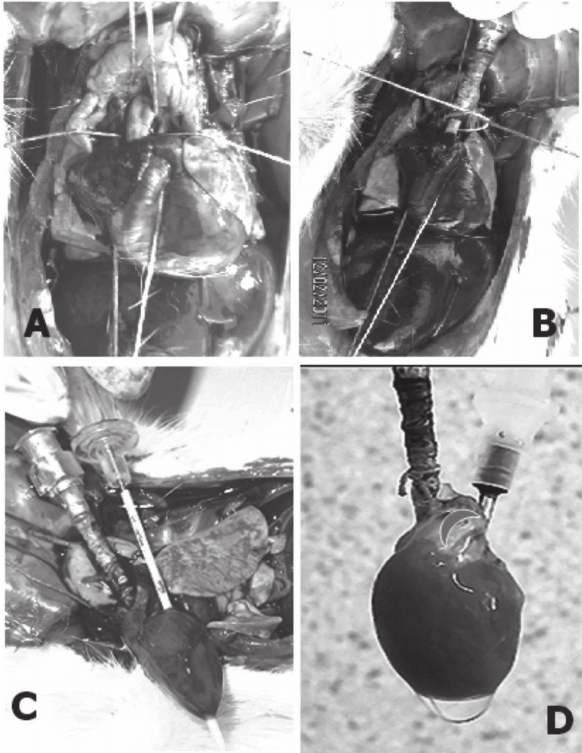
Fig. 1 – A: Ascending aorta was isolated with the 3-wire technique; B: Aortic cannula fixation; C: A multiperforated cannula through the left ventricle apex; D. A catheter-balloon in the left